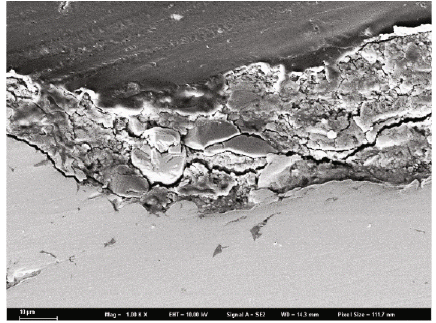
Figure 6: Micromorphology of the bridge deck cross